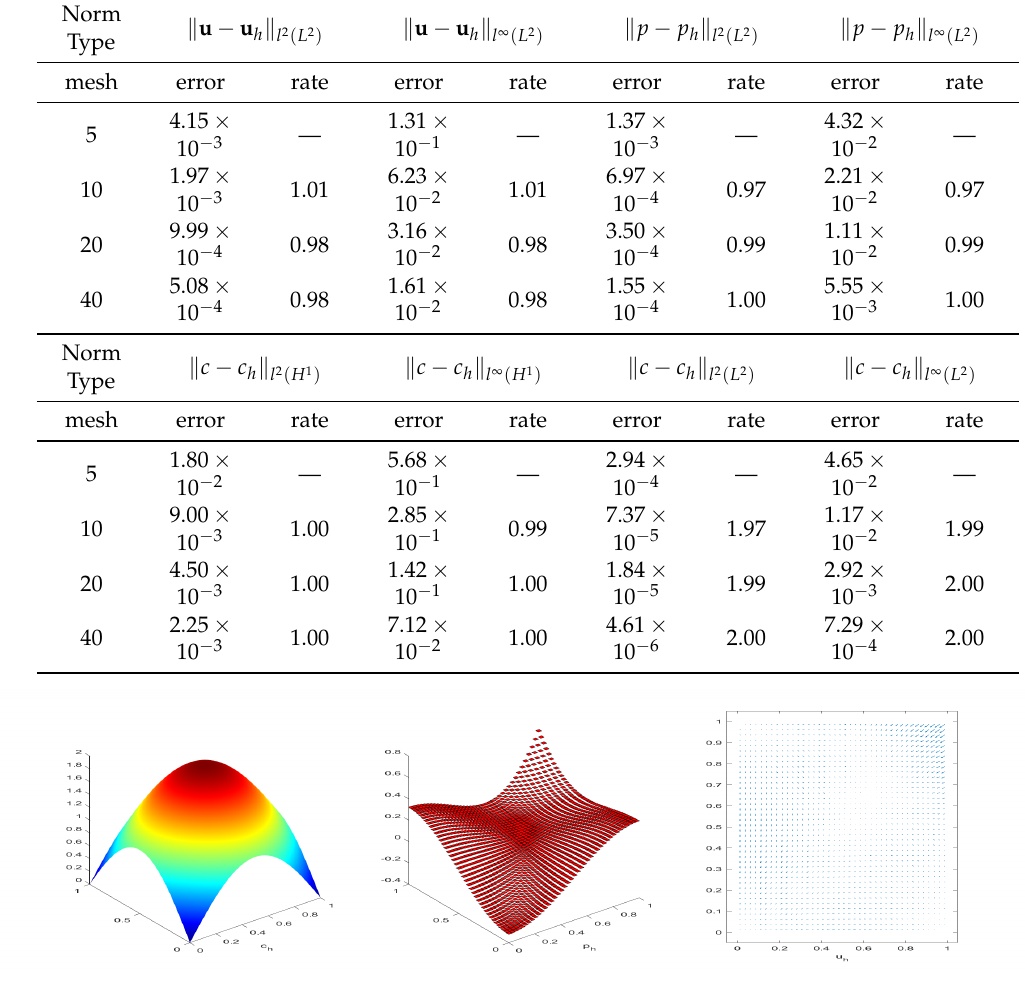
Figure 1. The graphs of the concentration, pressure, and velocity fields of Example